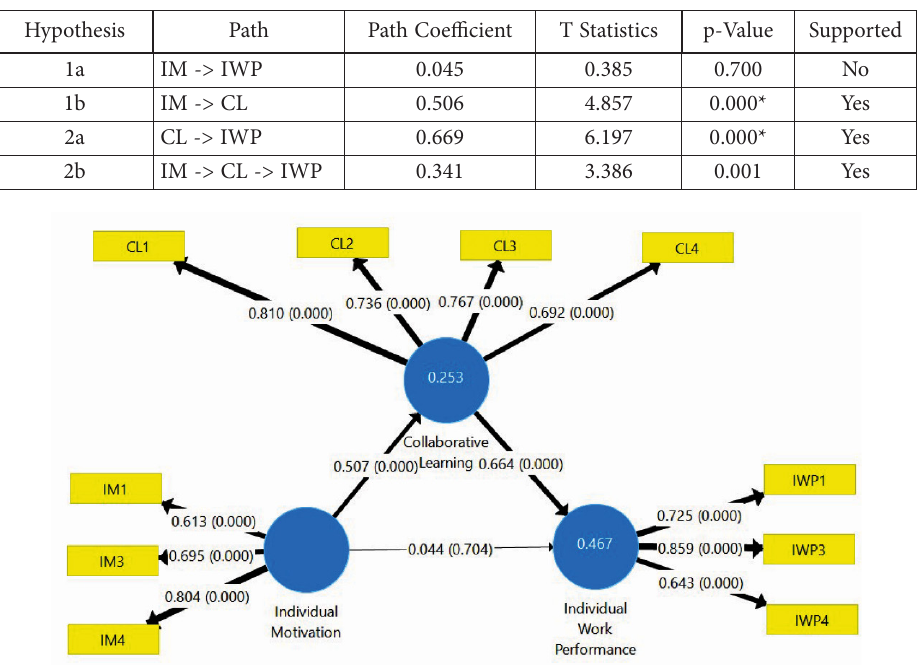
Table 7. Results of hypothesis testing